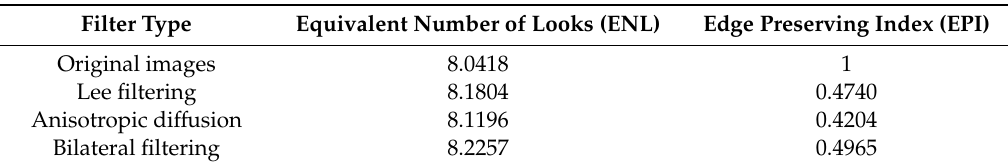
Table 5. Comparison of di ff erent noise reduction methods.